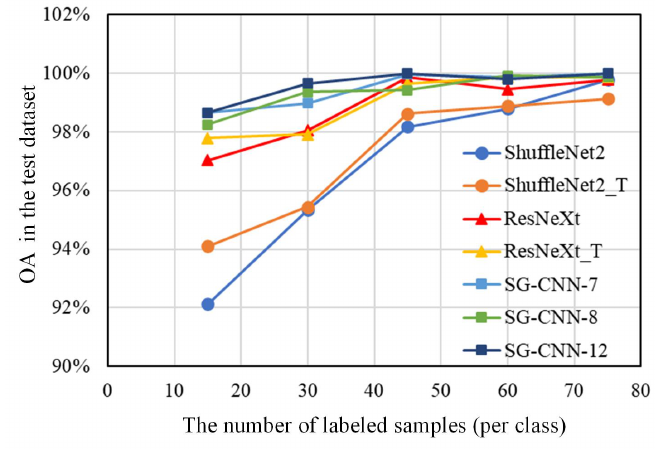
Figure 7. Overall classification accuracies of the test samples based on various methods trained/fine- tuned with 15–75 labeled samples for the Botswana scene.